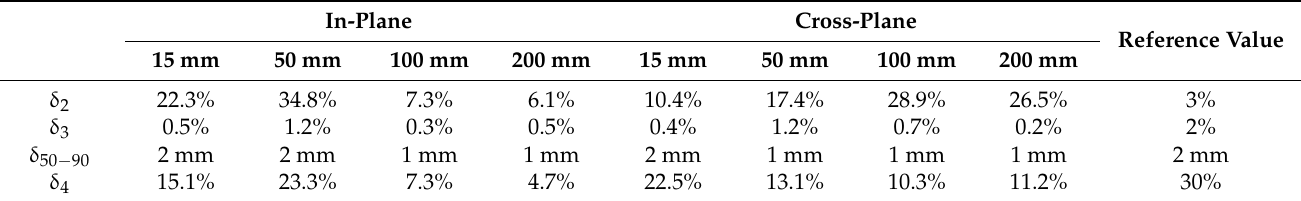
Table 2. Beam profile analysis of measured and simulated values for Varian Clinac 6MV: Data of 4 cm × 4 cm field size were analyzed at 15 mm, 50 mm, 100 mm, and 200 mm depths. Each part of beam profile was analyzed in order of δ 2 , δ 3 , δ 50–90 , δ 4 . All values were within criterion, except for δ 2, which represents high dose and high